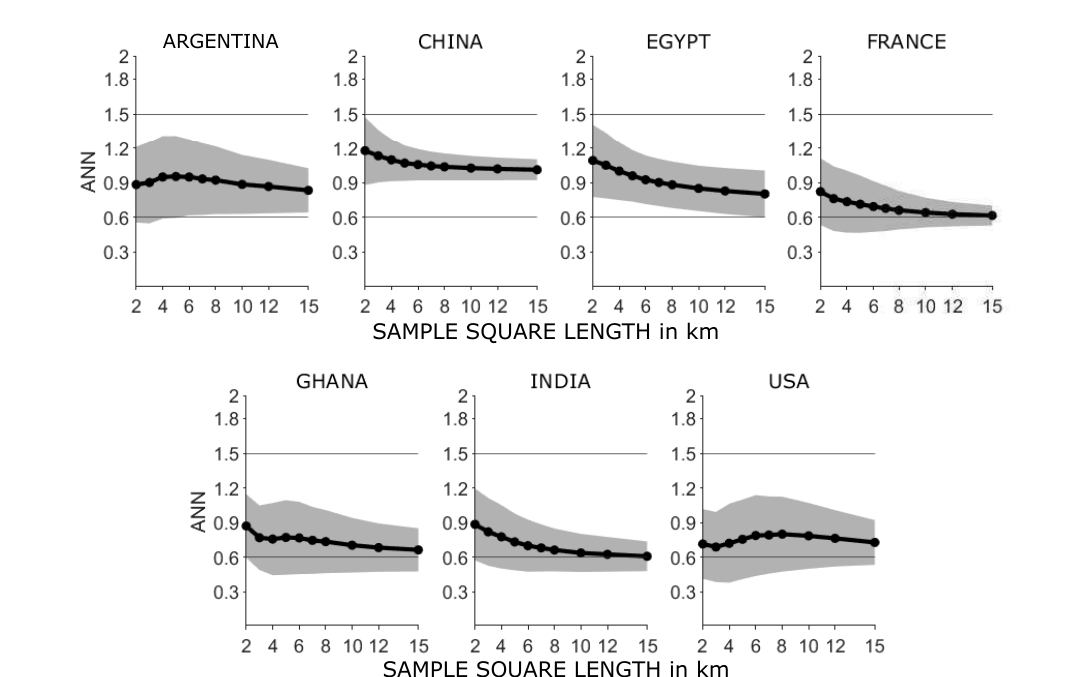
Figure 6. Results for the mean ANN calculated in sample squares of different edge length in all data sets. The grey area represents the standard deviation of the calculated